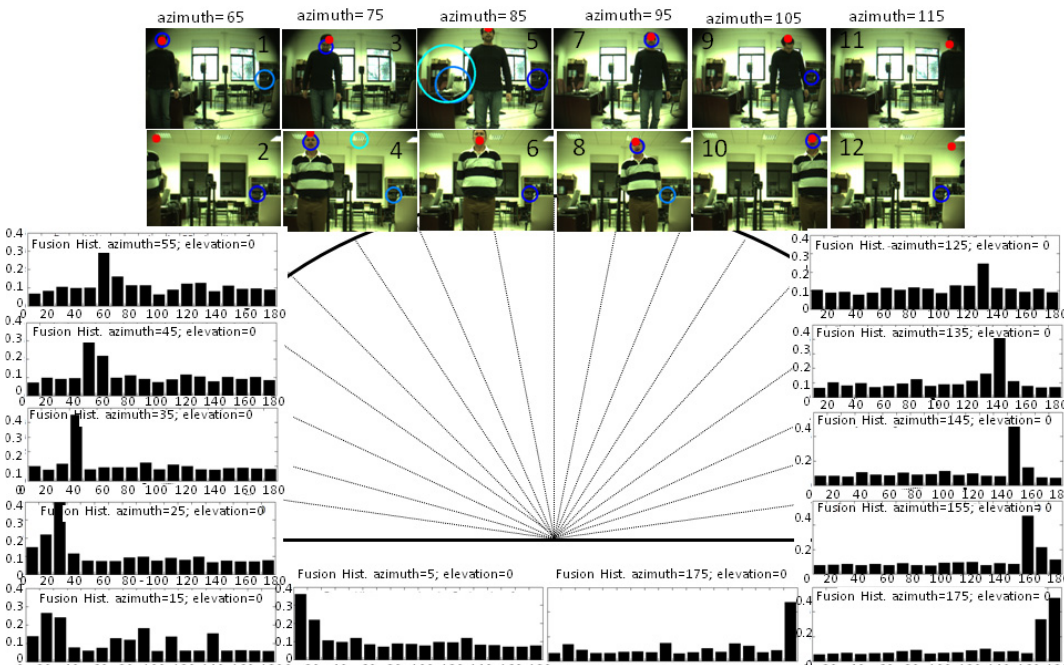
Figure 8. Tracking results obtained with different speakers and noise source conditions. The histograms show the evidence encountered for a detection of 1 s in different positions. The images show with a red circle the estimations of the multimodal sensor placed within the field of view. Blue circumferences show the face-detector